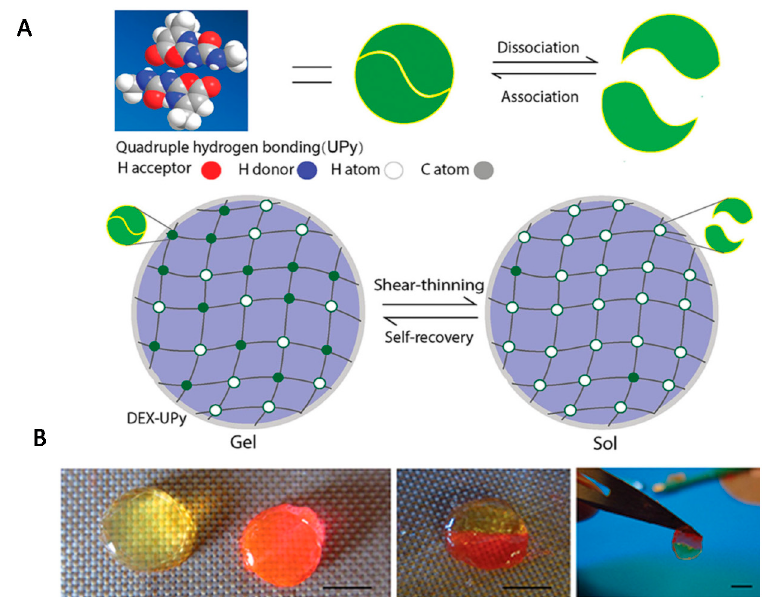
Figure 10. ( A ) Scheme of the experimental strategy for obtaining a DEX-UPy hydrogel with shear- thinning and self-integration properties; ( B ) visualization of these properties (scale bar corresponds to 5 mm). Reprint with permission [152]; Copyright 2015, Wiley.